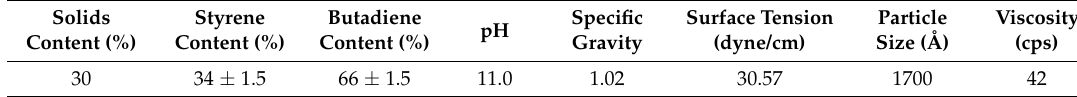
Table 4. Properties of styrene butadiene latex.